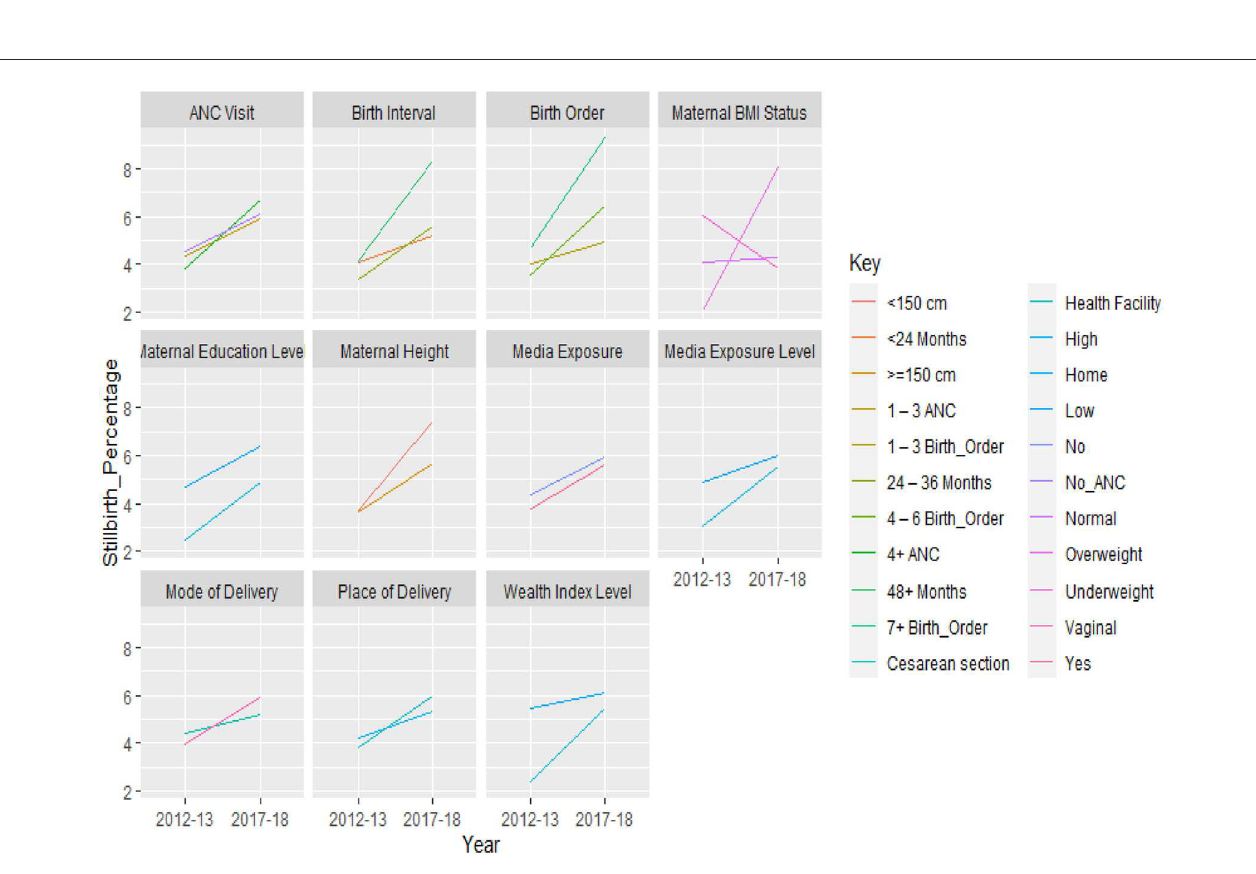
FIGURE3 Trend in the stillbirth rate between surveys, by selected labor, delivery care and other characteristics, (PDHS 2012–2013 and PDHS